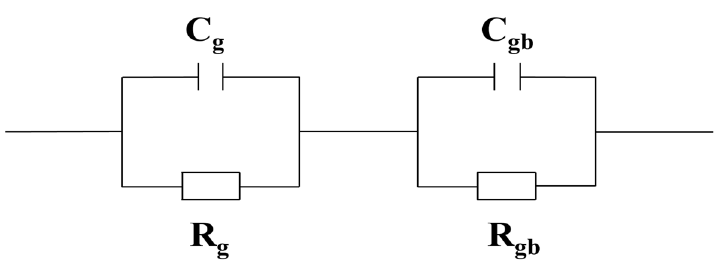
Figure 8. Equivalent circuit used for establishing the parameters of the IBLC model.